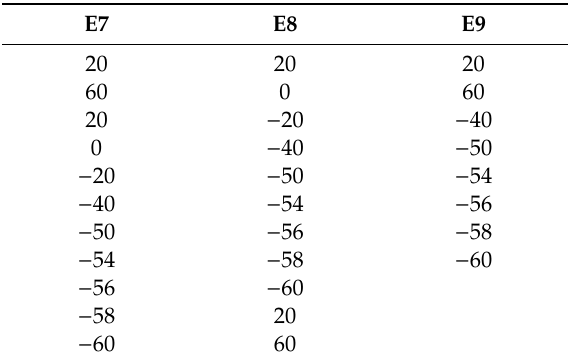
Table 3. Temperature ( ◦ C) sequence for leakage rate measurements performed on lubricated EPDM seals E7, E8, and E9 aged at 150 ◦